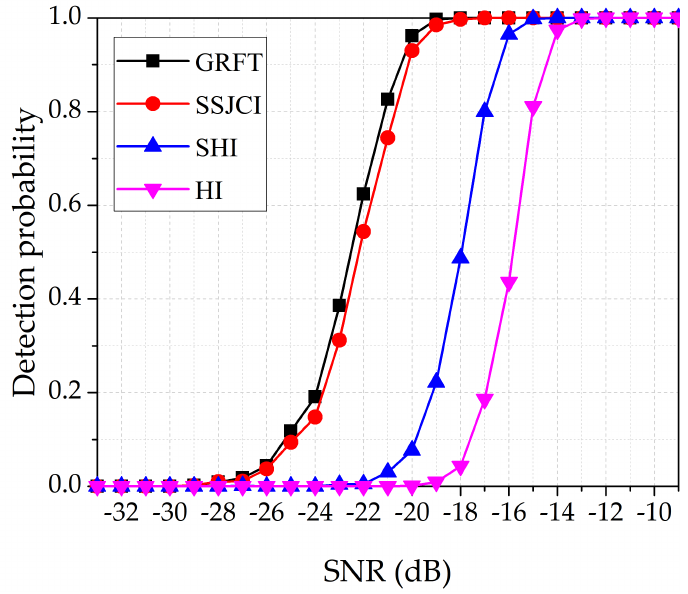
Figure 8. Detection probabilities of HI, SHI, SSJCI, and GRFT